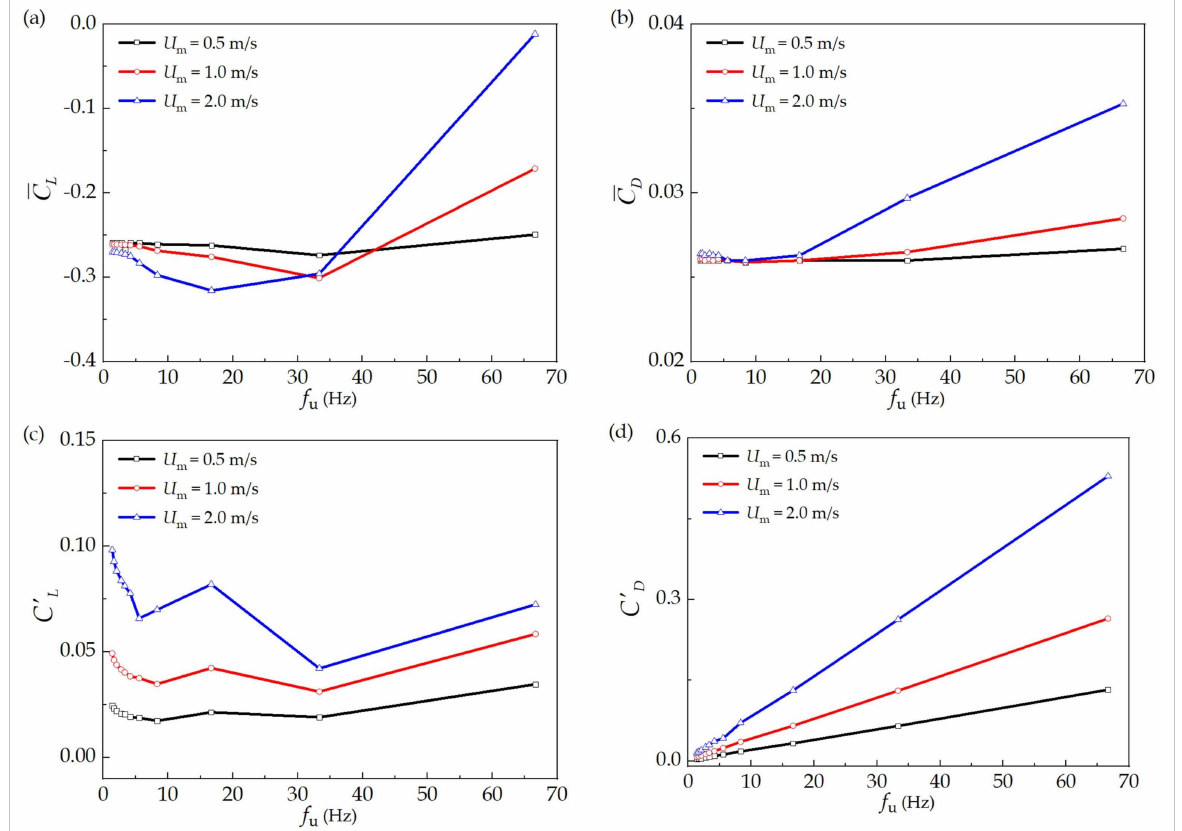
Figure 12. Mean and RMS aerodynamic force of the girder in streamwise oscillating flows: ( a ) mean lift force; ( b ) mean drag force; ( c ) RMS lift force; ( d ) RMS drag